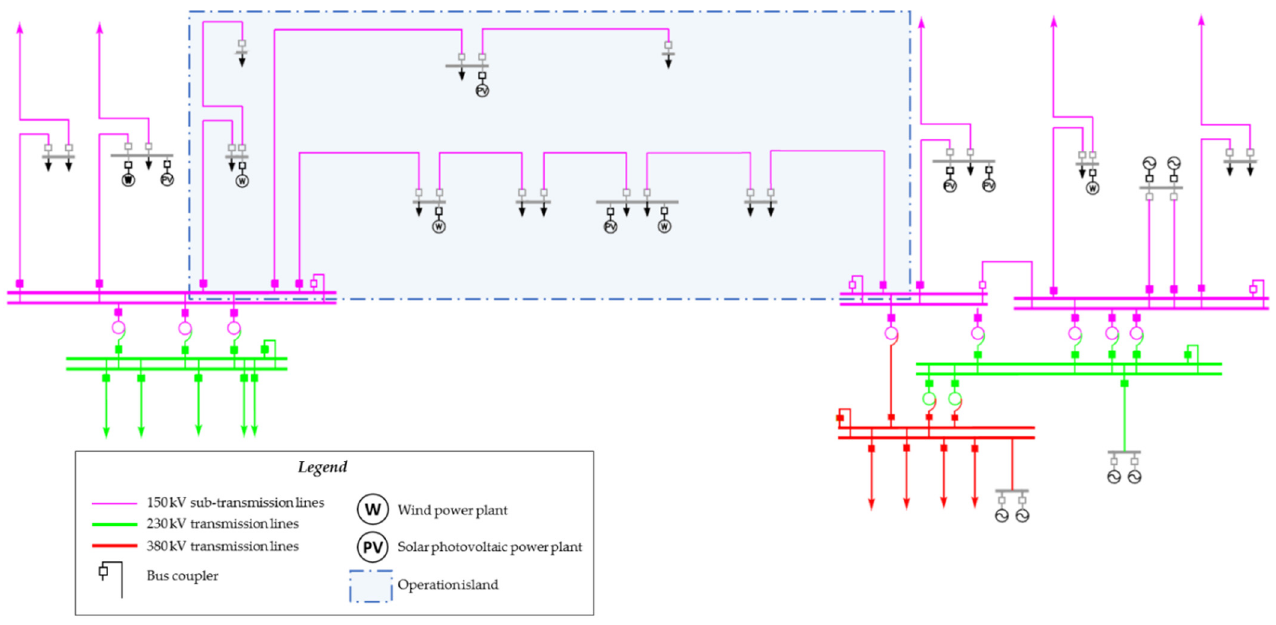
Figure 5. Typical architecture of HV operation